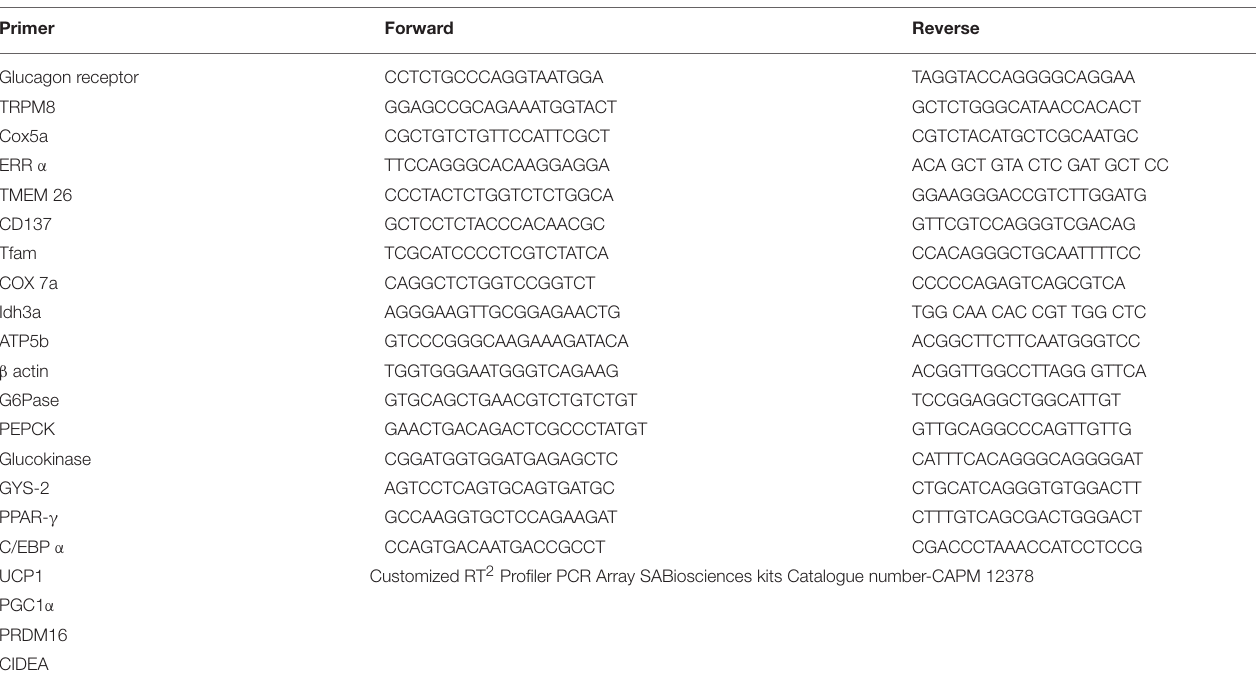
TABLE 1 | Sequence of primers used in this